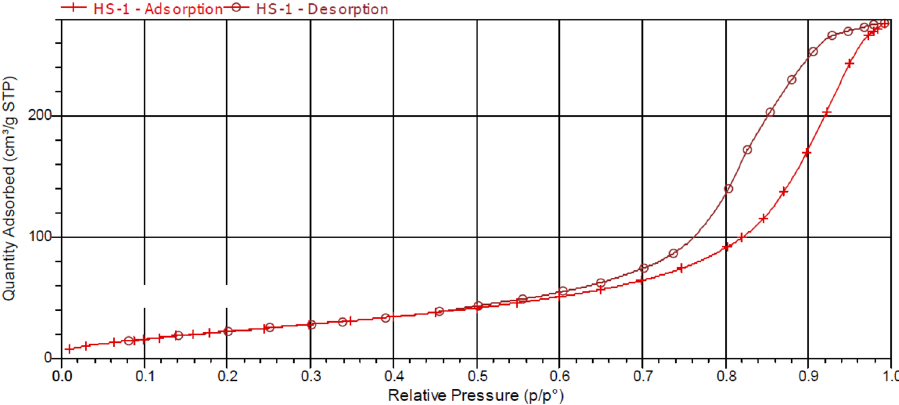
Figure 5. Nitrogen adsorption–desorption isotherms of the new catalyst with MnO 2 nanosheets grown on carbon microfibers.